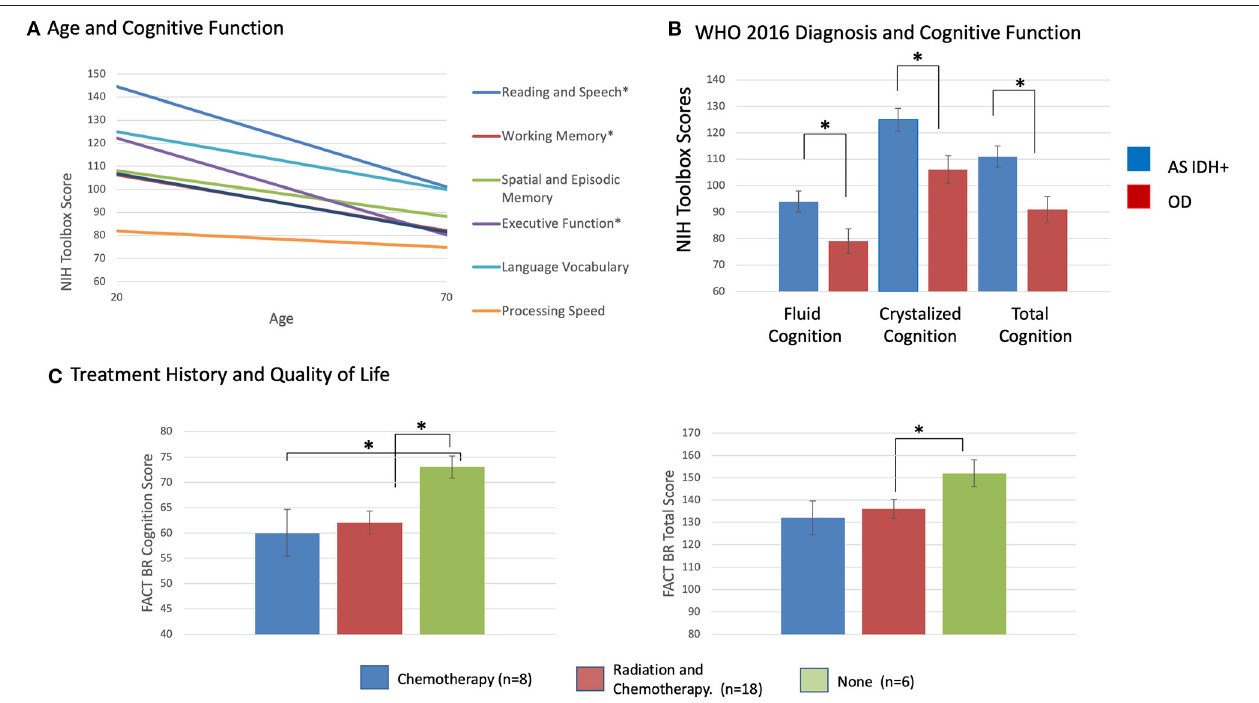
FIGURE 2 | (A) Mean age-corrected cognition subscores from the NIH Toolbox by patient age, * p < 0.05, corrected for multiple comparisons. (B) Mean age-corrected cognition summary scores from the NIH Toolbox by WHO 2021 molecular diagnostic subgroup, * p 0.05, corrected for multiple comparisons. (C) Mean FACT-BR cognition subscore, FACT-BR Total score by patient radiation and chemotherapy history, * p < 0.05, corrected for multiple